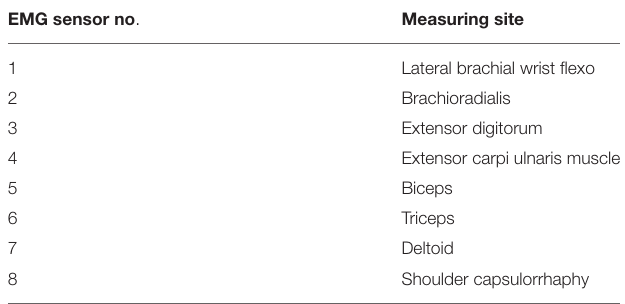
TABLE 1 | The distribution location and the serial number of the EMG sensors. EMG sensor no